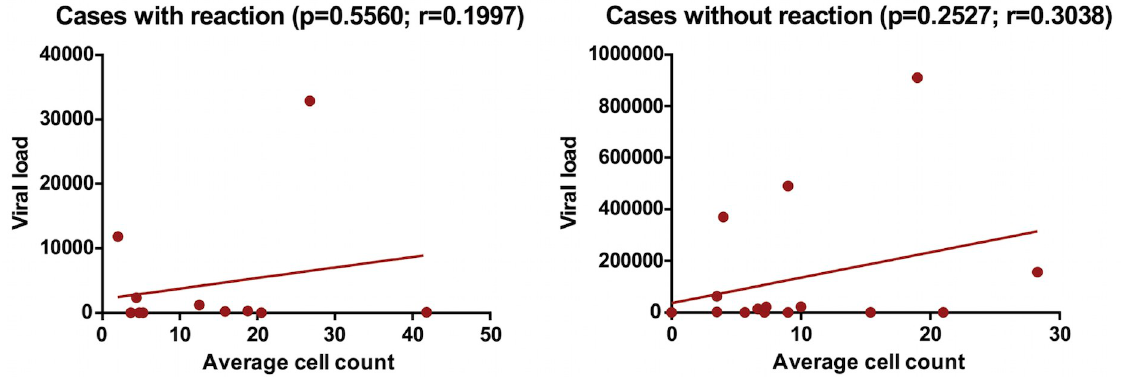
Fig 2. Cells marked with FOXP3 and viral load among HIV/leprosy co-infected patients, according to the presence of reverse reaction.